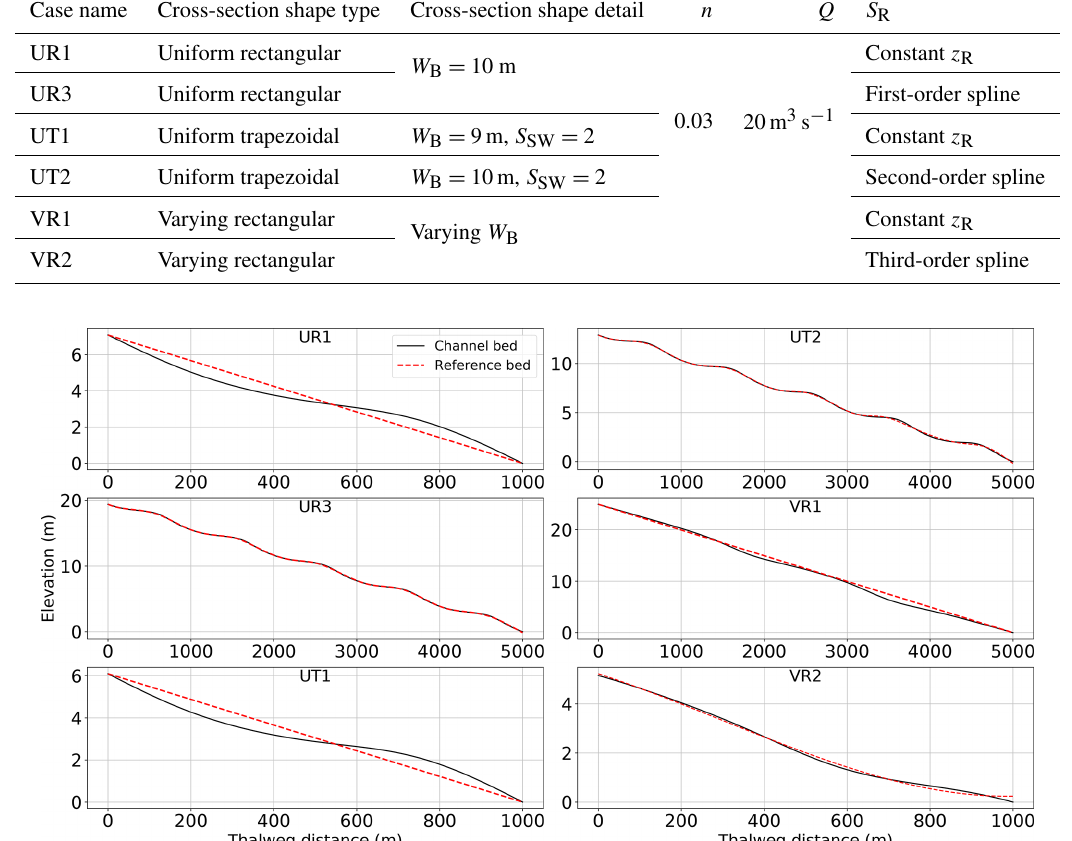
Figure 5. Channel bed elevation ( z 0 ) and reference bed elevation ( z R ) for six test cases from MacDonald et al. (1995).